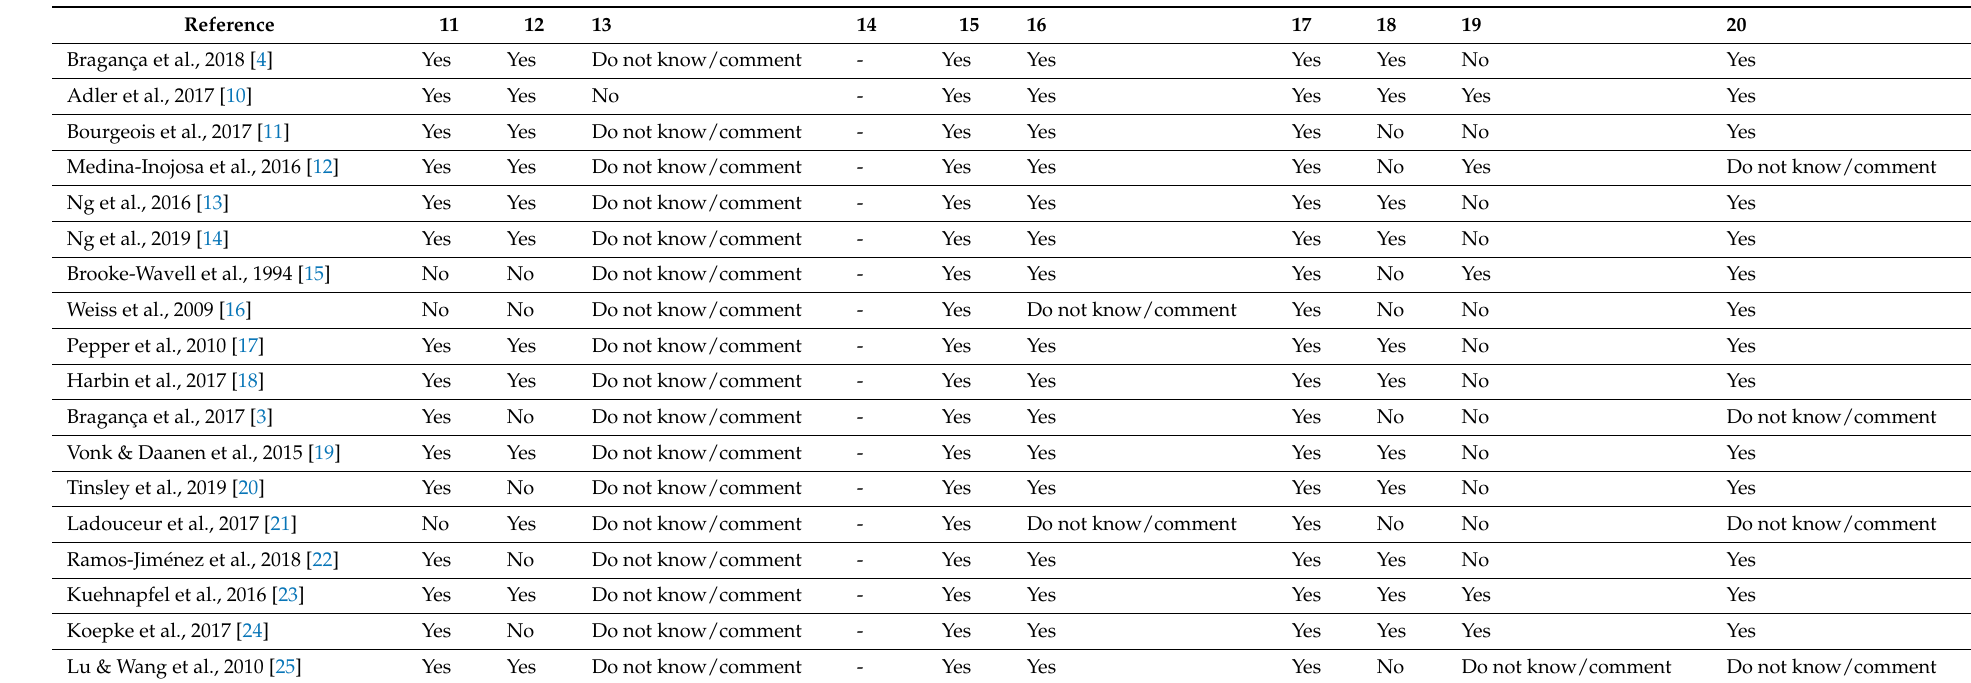
Table 3. Last ten questions from the AXIS